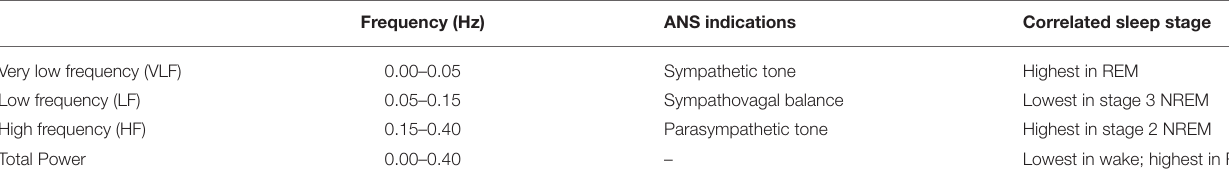
TABLE 1 | Summary chart of correlations of HRV frequency bands to sleep